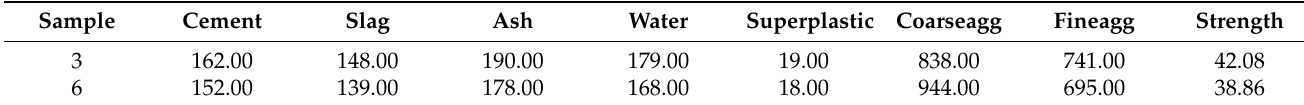
Figure 4. Box plot outlier recognition. There are two values in the feature superplastic that exceed the upper boundary and are identified as outliers. Table 3. The box plot identifies each eigenvalue of two abnormal samples.